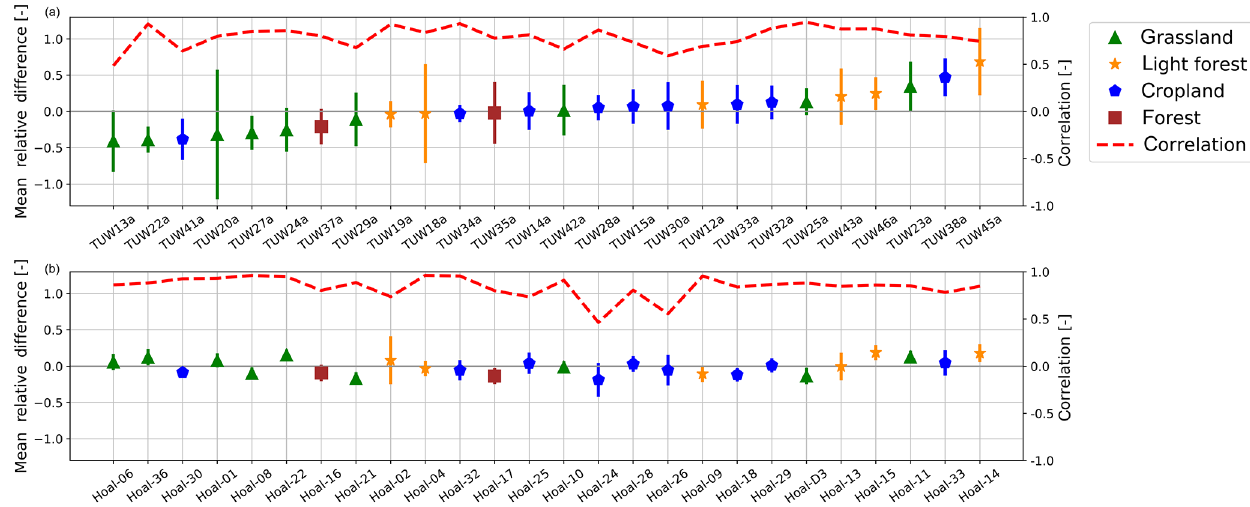
Figure 10. Mean relative differences (MRD) for (a) FP sensors and (b) corresponding professional probes at a depth of 0.05m, sorted by the MRD of the FP sensors. In addition, the correlation between the catchment average and individual sensors is shown.